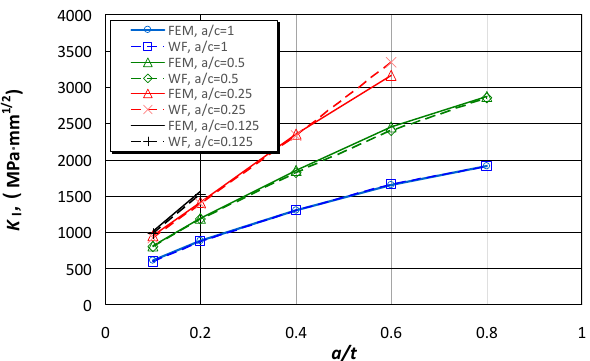
Figure 9. SIF solutions for crack perpendicular to weld line ( α = 90°).